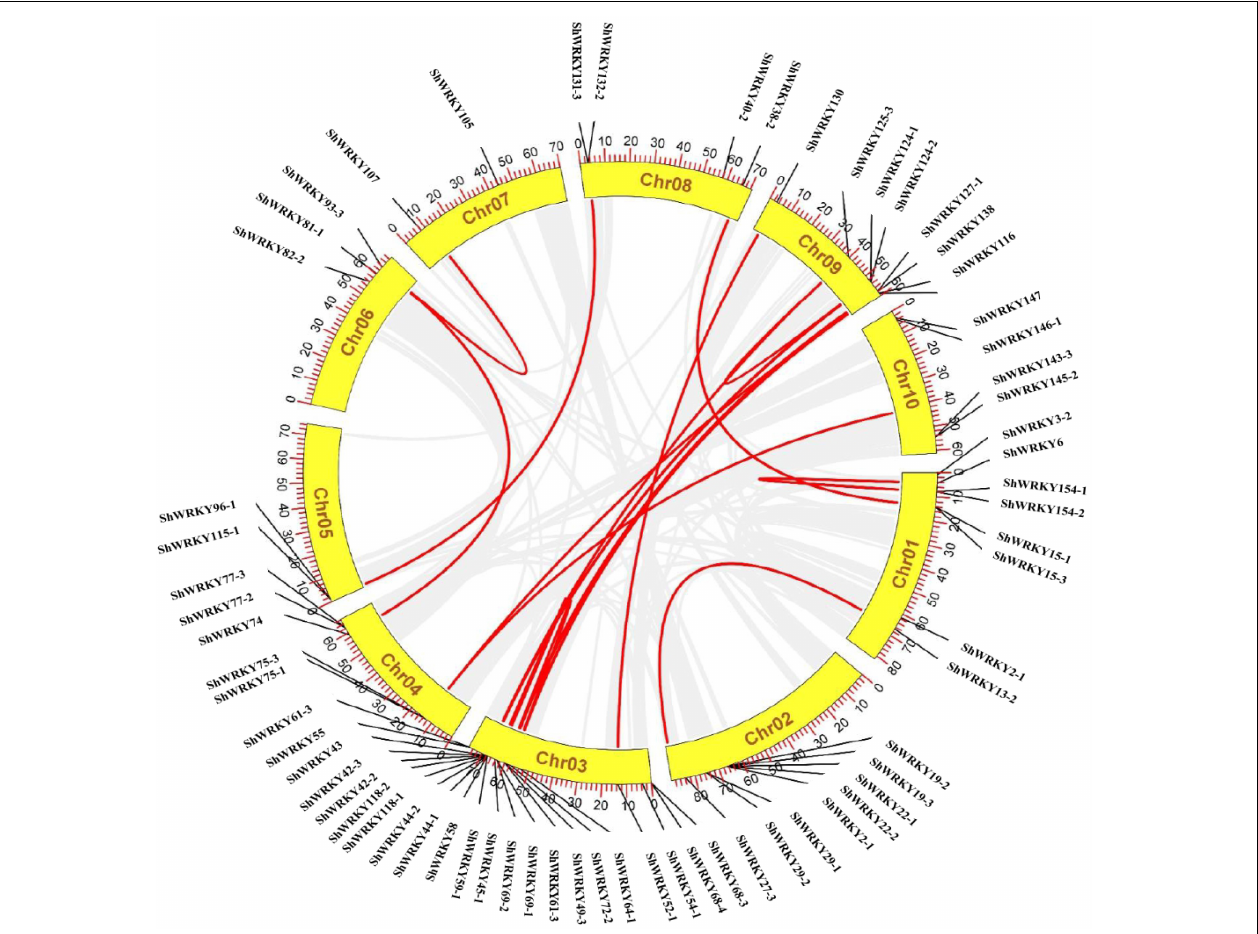
FIGURE 4 | Chromosomal distribution of ShWRKY genes in Saccharum spp. hybrid R570. Ribbon links (Red lines) indicate segmental duplication events between genes. Chromosome numbers are indicated inside the yellow segments. Chr01 to Chr10 are currently based on Sorghum bicolor genome scaffolds (https://phytozome-next.jgi.doe.gov/info/SbicolorSC187_v1_1). The Saccharum spp. R570 gff3 file contains these 10 chromosomes and all BAC clones that could not be placed. The gene names on each chromosome are indicated in the outer